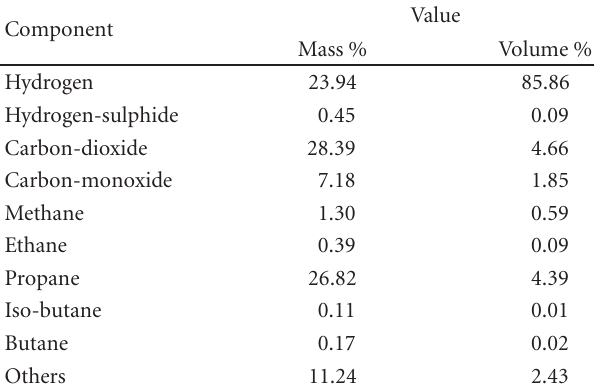
Table 2: Composition of the gas product ( T = 360 ◦ C, P = 80bar,